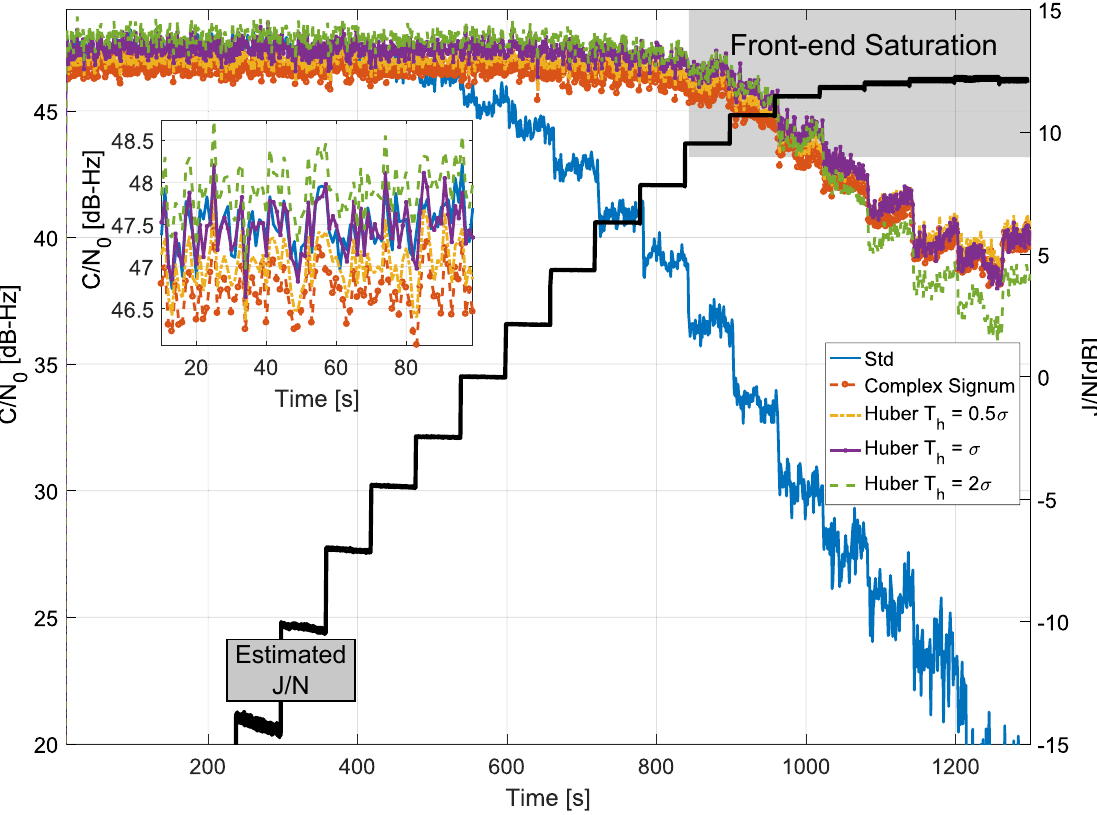
Figure 12. Comparison of C / N 0 values obtained considering different frequency domain processing schemes. Anechoic chamber test with Galileo E1c